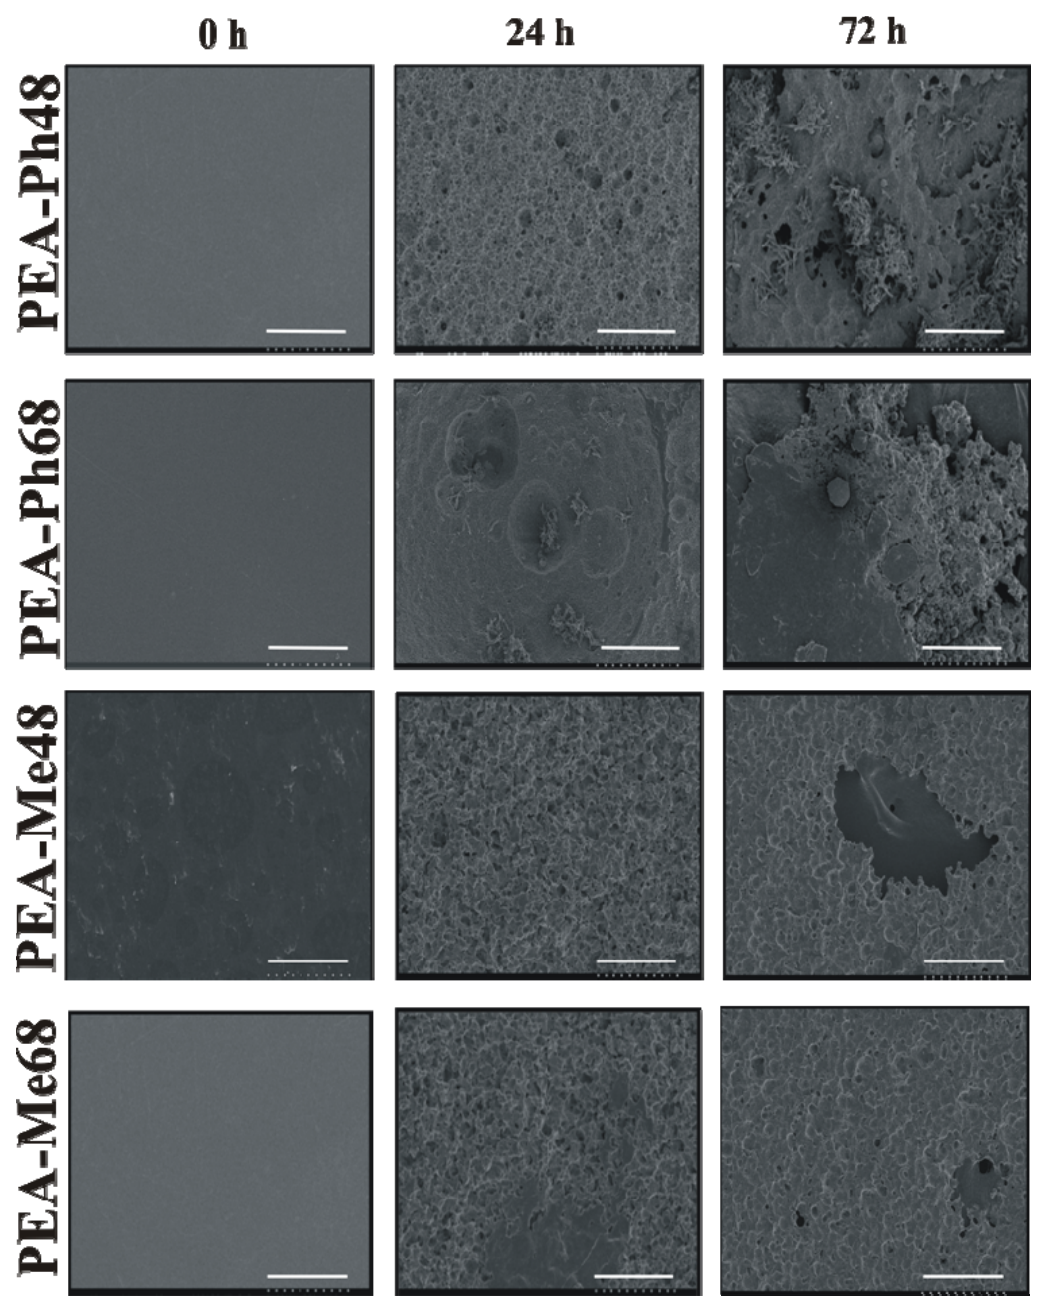
Figure 8. SEM images of PEA films following 72 h of incubation in chymotrypsin at 37 °C. All polymers showed an extensive erosion but the L -phenylalanine PEAs are the most eroded. Scale bar = 100 μ